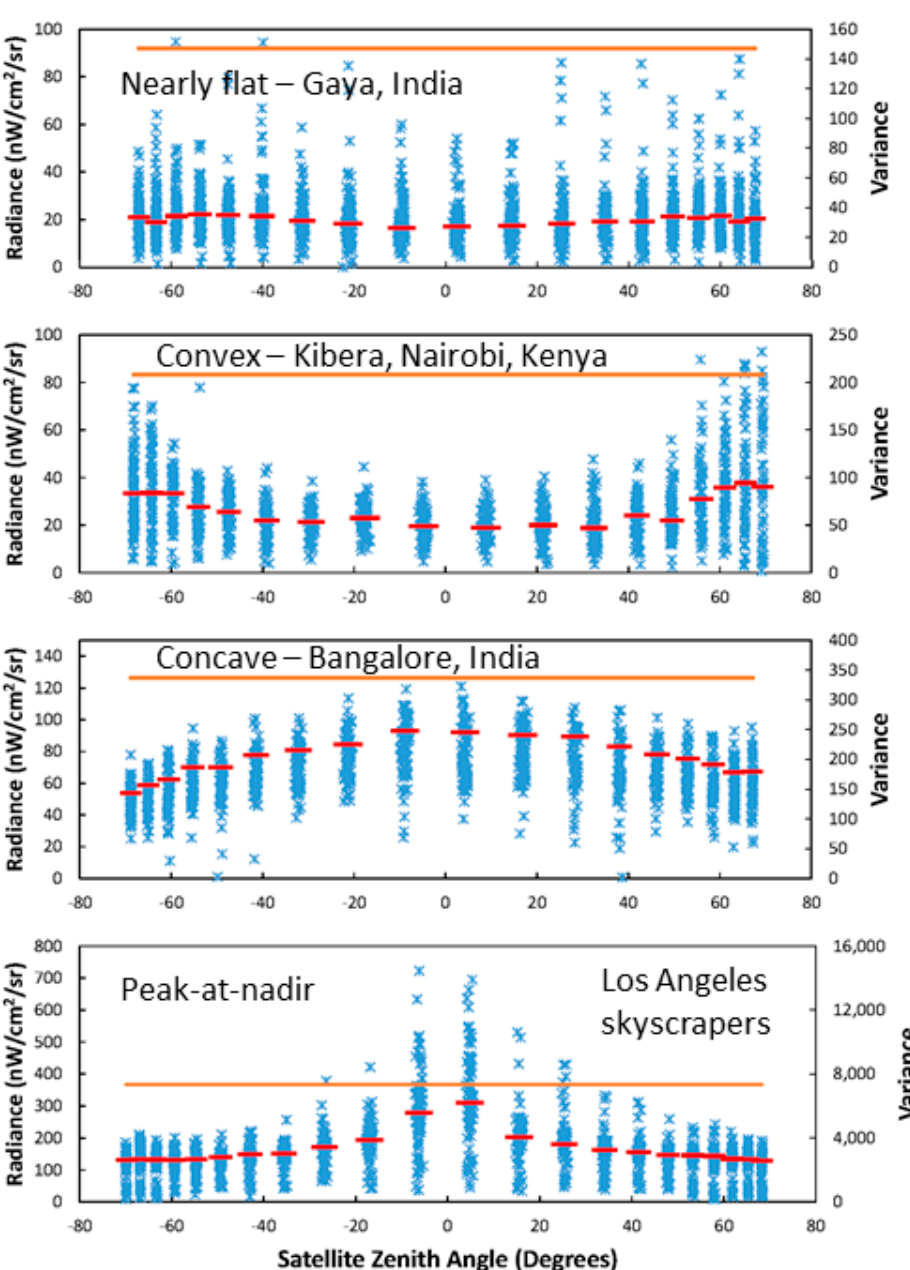
Figure 7. DNB radiance versus the satellite zenith (satz) angle profiles fall into four primary types: flat, convex, concave, and peak at nadir. For any location on the ground, there are a limited set of possible satz positions due to orbit precession. The red lines mark the median positions for each satz column. The orange horizontal line marks the inter quartile range (IQR).